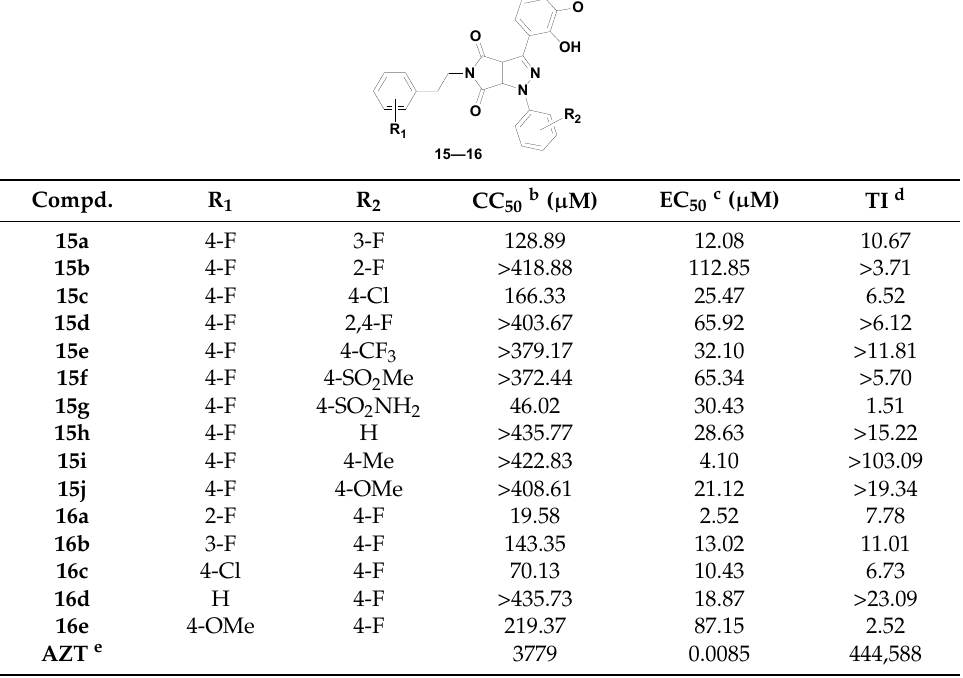
Molecules 2016 , 21 , 1198